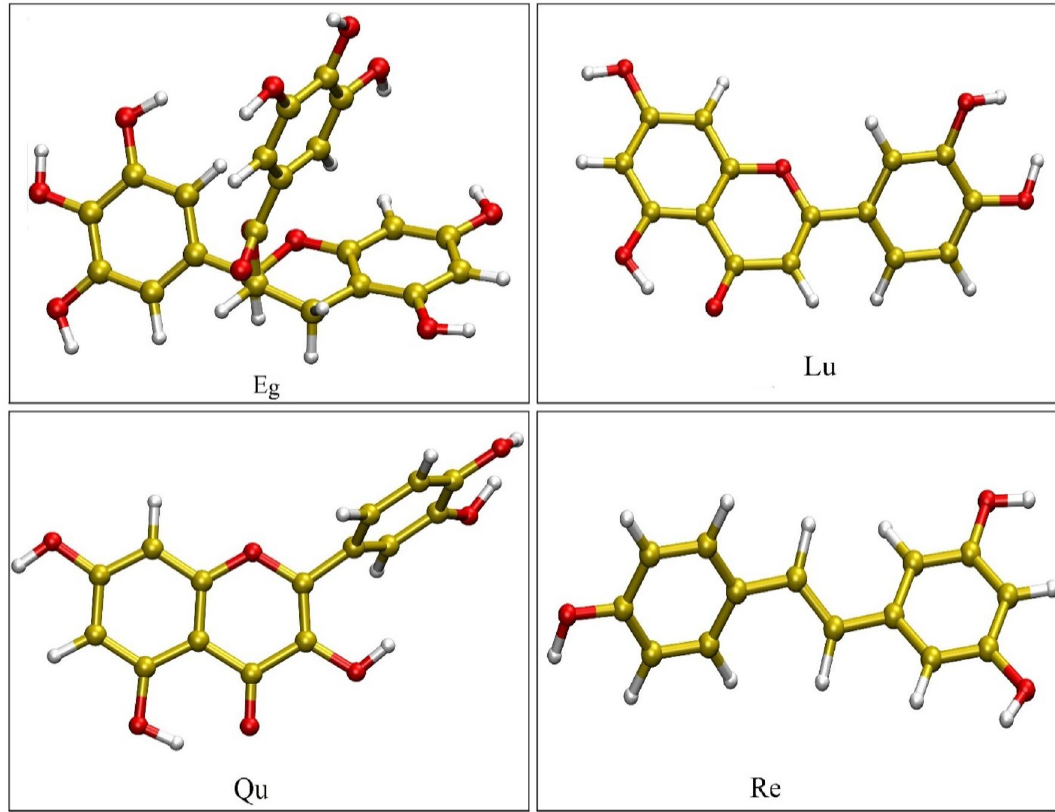
Figure 2. The chemical structures of Epigallocatechin-3-gallate (EG), luteolin (Lu), quercetin (Qu), and resveratrol